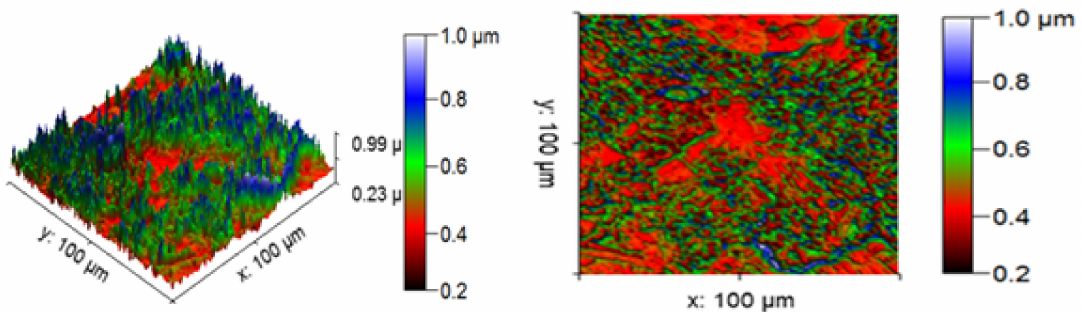
Figure 29. Corrosion test specimen (moderate corrosion).